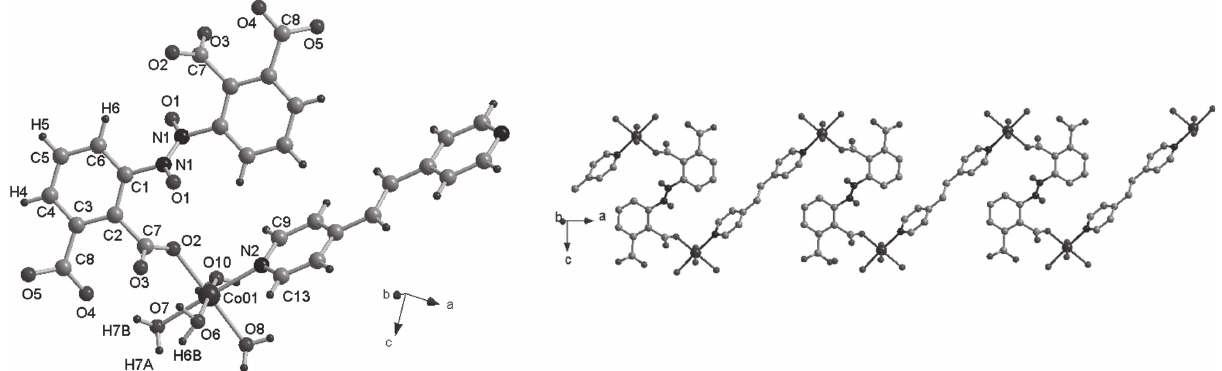
Table 1: Data collection and handling.